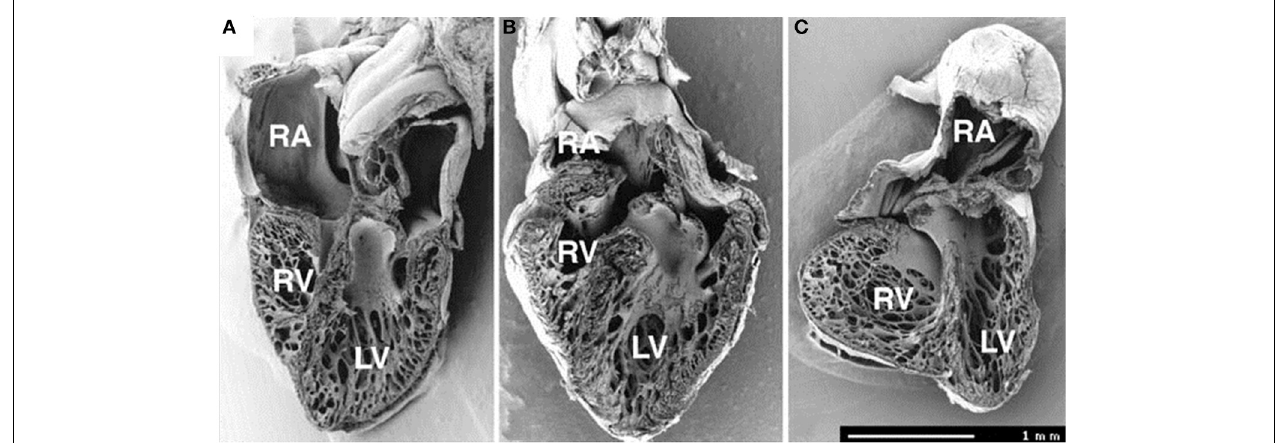
FIGURE 5 | Frontal dissection of HH34 sham (A), OTB (B), and LAL (C) hearts. Note distorted atria, changed proportions of the ventricles and defect of interventricular septum in the LAL embryo. The trabeculae in the LV show precocious adherence to the lateral wall and changed orientation with circumferential alignment in the right. The muscular flap-like morphology of the right atrioventricular valve is changed to a bicuspid,